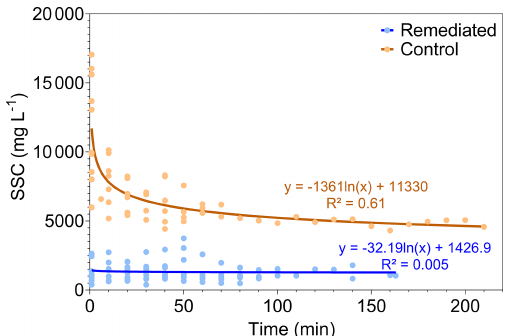
Figure 5. Relationship between time after initiation of flow and SSC of samples collected from the control (brown) and remediated (blue) gullies using autosamplers and RS samplers during the 2017– 2018 and 2018–2019 wet seasons. Trend lines represent logarithmic regression